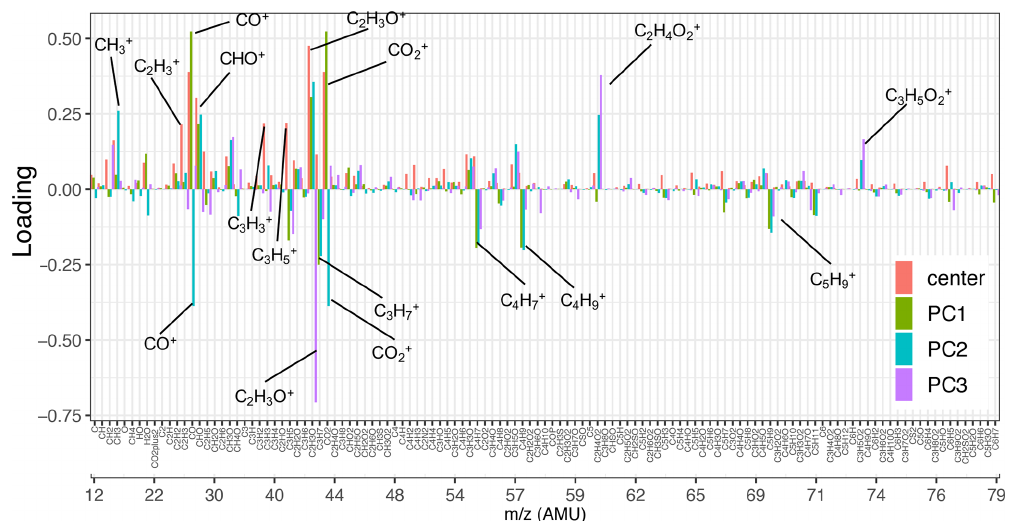
Figure 3. Loadings of the first three principal components and the normalized mean AMS mass spectrum (shown up to m/z 80). Fragment ions with high positive/negative loadings are indicated by their formula. Refer to Fig. S6 for the heavier